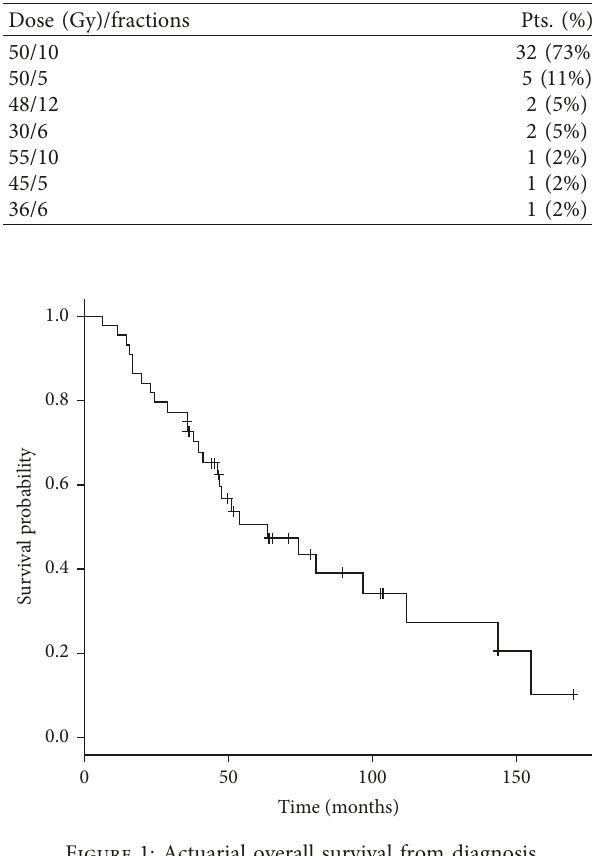
Figure 1: Actuarial overall survival from diagnosis.